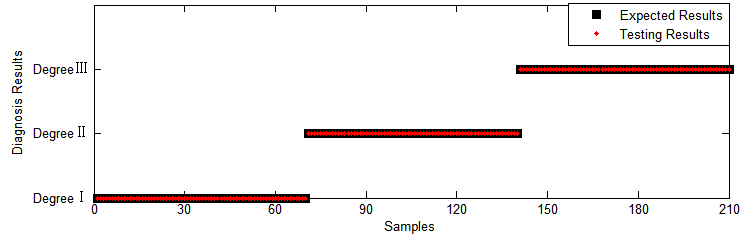
Figure 13. Diagnosis results of inner race fault severity estimation based on the BPNN_IR network and decision fusion.